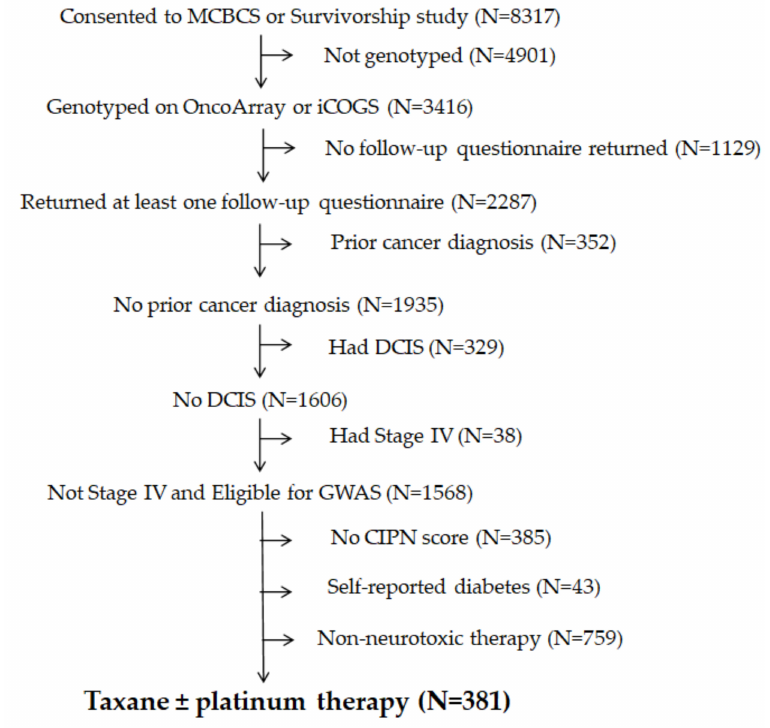
Figure 1. Breast registry flow diagram. DCIS: ductal carcinoma in situ; GWAS: genome-wide association study; CIPN: chemotherapy-induced peripheral neuropathy; MCBCS: Mayo Clinic Breast Cancer survey; iCOGS: Illumina iSelect genotyping array, designed as part of the Collaborative Oncological Gene-Environment Study